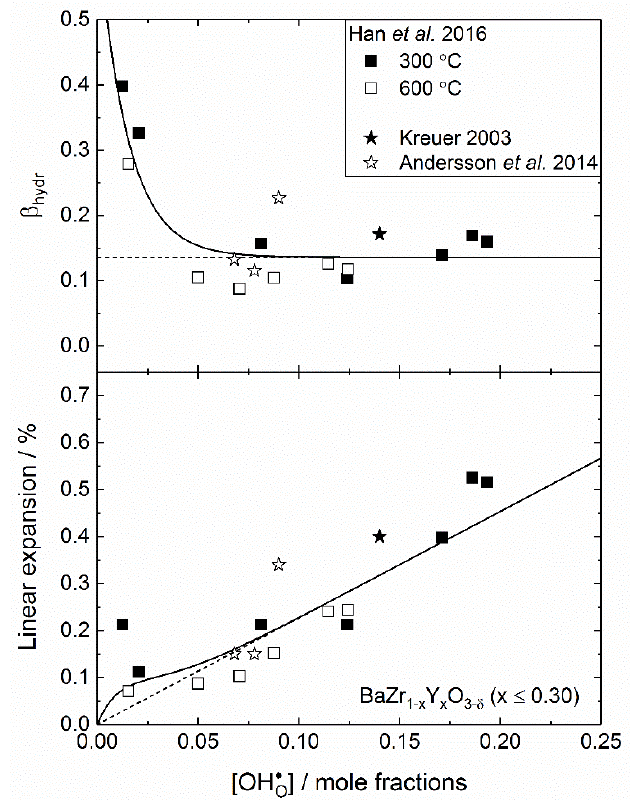
Figure 5. Experimentally determined chemical expansion coefficients upon hydration per mol H 2 O, β hydr , for BaZr 1 − x Y x O 3 − δ as a function of the proton concentration, [ OH O• ] in the top panel, along with the corresponding linear expansion of the lattice in the bottom panel [77,78,80]. The solid lines are based on an exponential decay function fitted to all values of β hydr (top panel) and the same function is used to express the linear expansion (bottom panel). The dashed lines represent the chemical expansion when β hydr is constant (0.136).